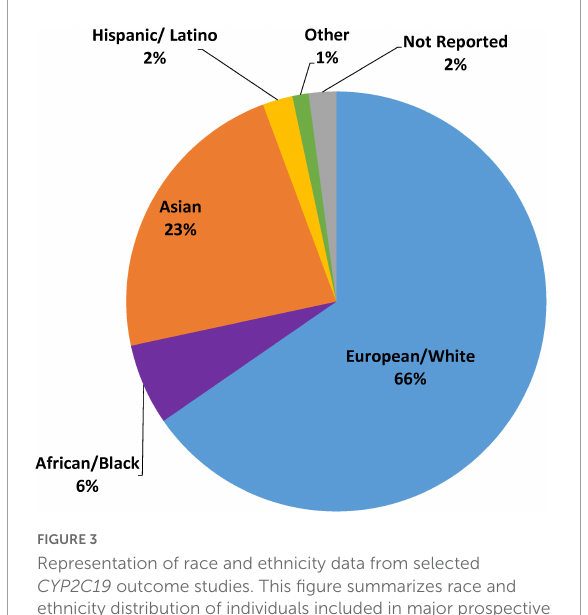
FIGURE3 Representation of race and ethnicity data from selected CYP2C19 outcome studies. This figure summarizes race and ethnicity distribution of individuals included in major prospective clinical outcome studies of CYP2C19 genotype guided antiplatelet therapy (as summarized in Supplementary Table 1 ). Pie graph displays aggregated percent race and ethnicity composition from the N = 12,467 patients enrolled in the 4 studies with reported race and ethnicity data (TAILOR PCI, POPular Genetics, IGNITE,